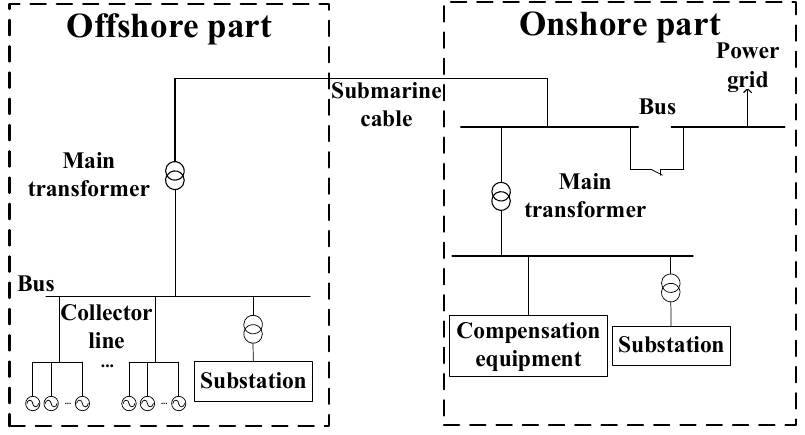
Figure 1. The structure of a typical offshore wind